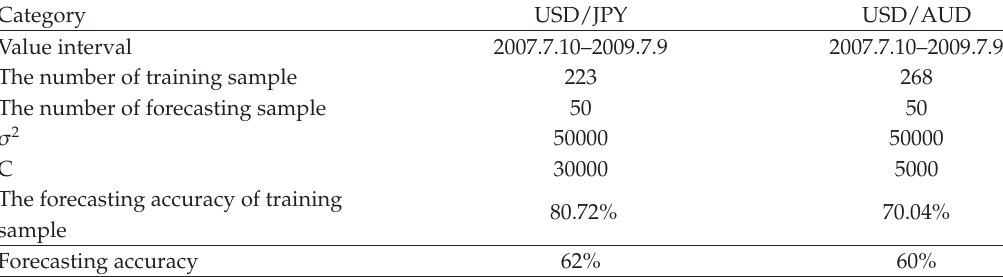
Table 3: Predicting results of other exchange